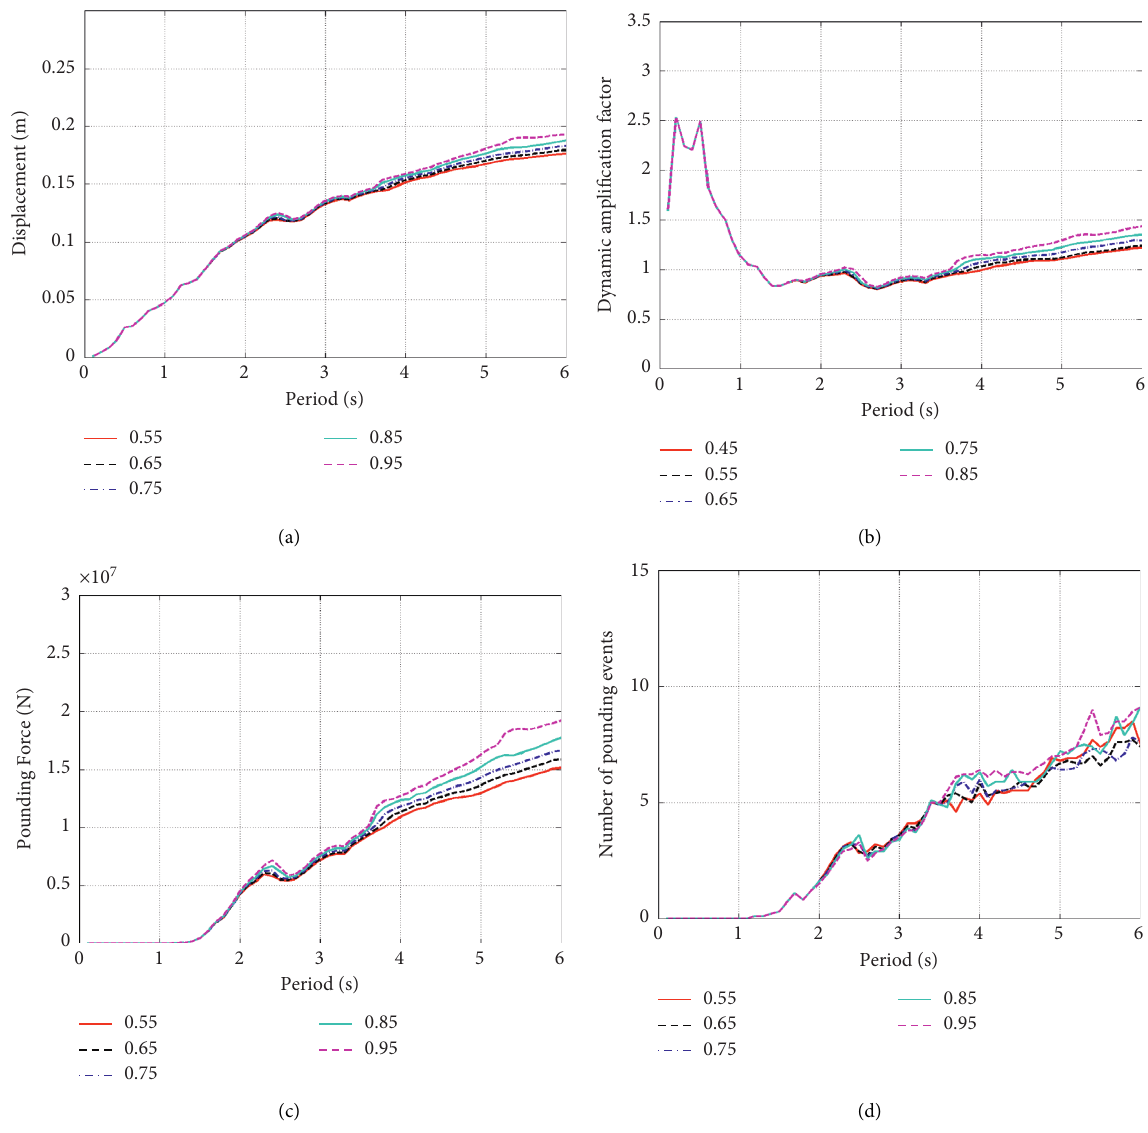
Figure 14: Average spectrum analysis results of different pounding recovery coefficients. (a) Displacement spectrum. (b) Dynamic amplification factor spectrum. (c) Pounding force spectrum. (d) Number of pounding event response